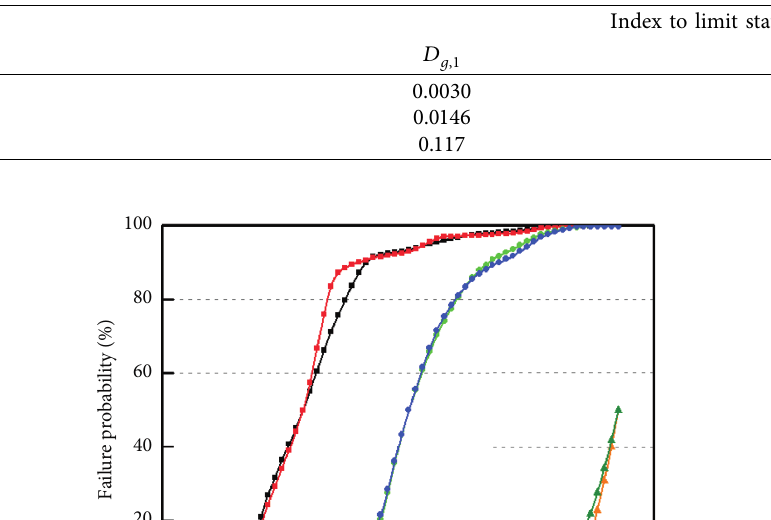
Table 4: Mean values of damage indices under various limit states.